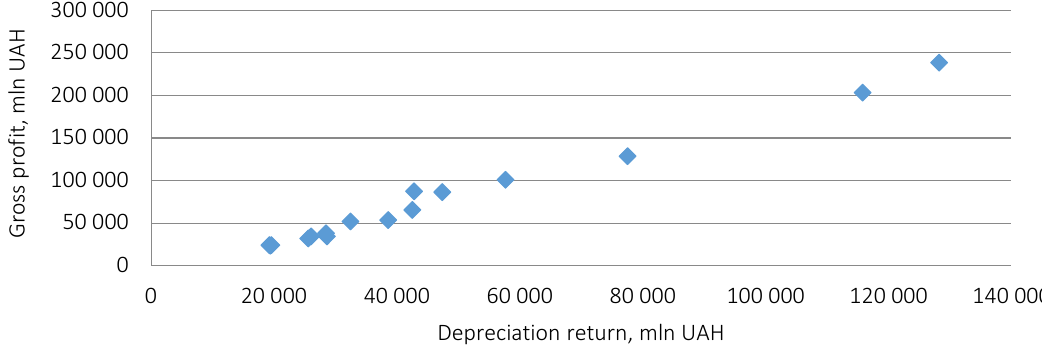
Table 3. Results of correlation analysis Indicators to test the hypothesis about the reliability of the correlation coefficient Correlation coefficient